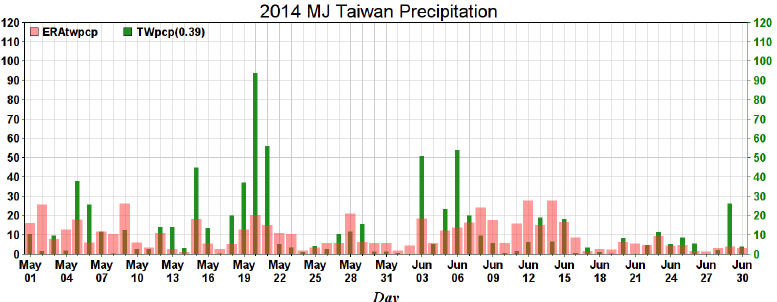
Figure 2. Time-series of yearly correlation coefficients between station precipitation (TWpcp) and ERA5 precipitation (ERA5twpcp) average over Taiwan (120° E–122° E, 21.5° N–26° N) ( a ). ( b ) Location of eight stations of CWB in Taiwan.